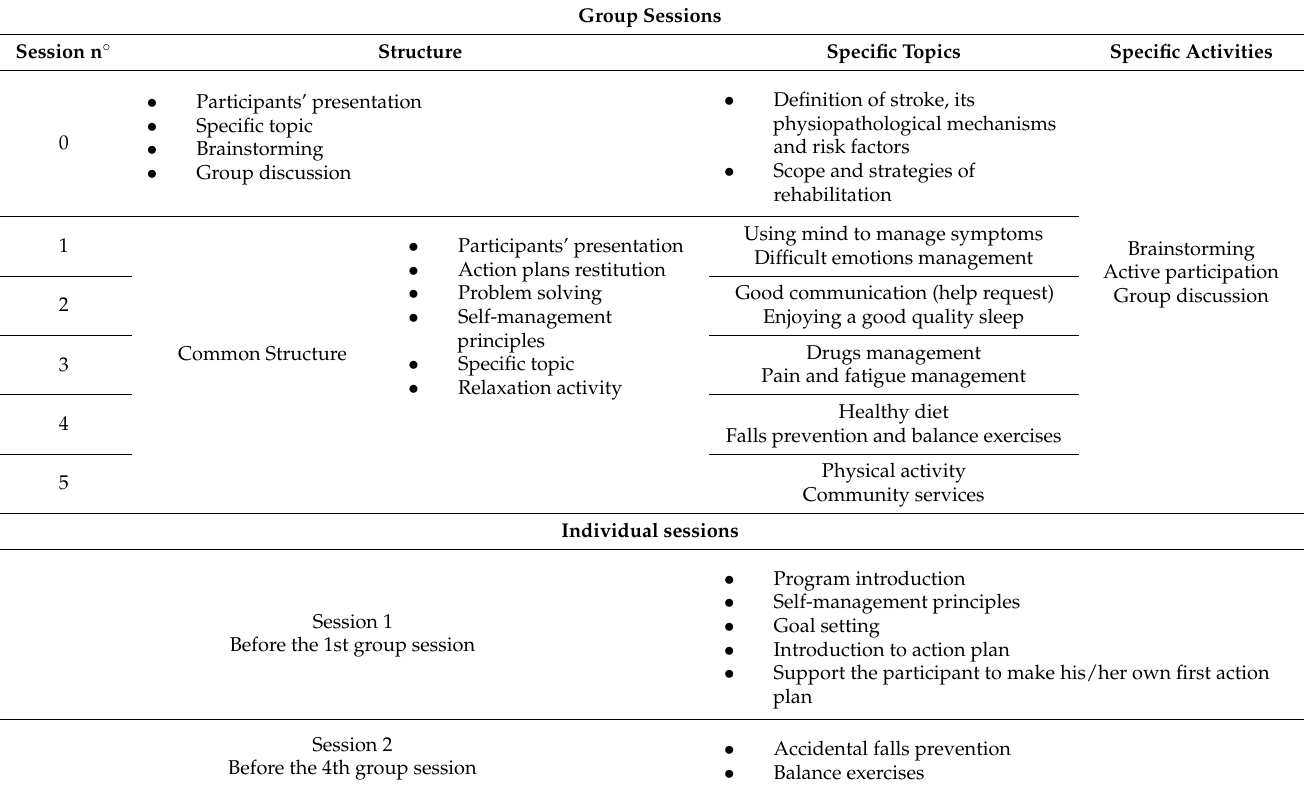
Table 2. Summary of the activities and topics addressed during LAY